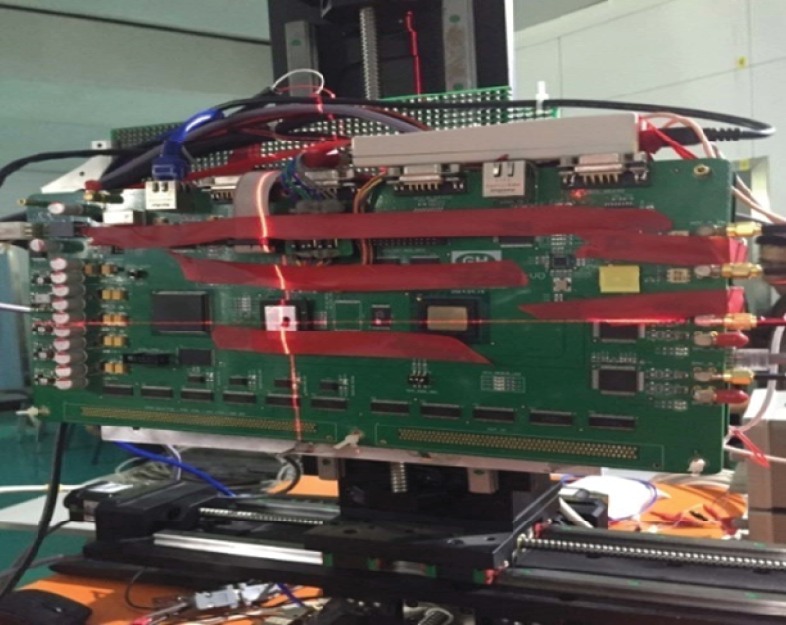
Real testing figure.